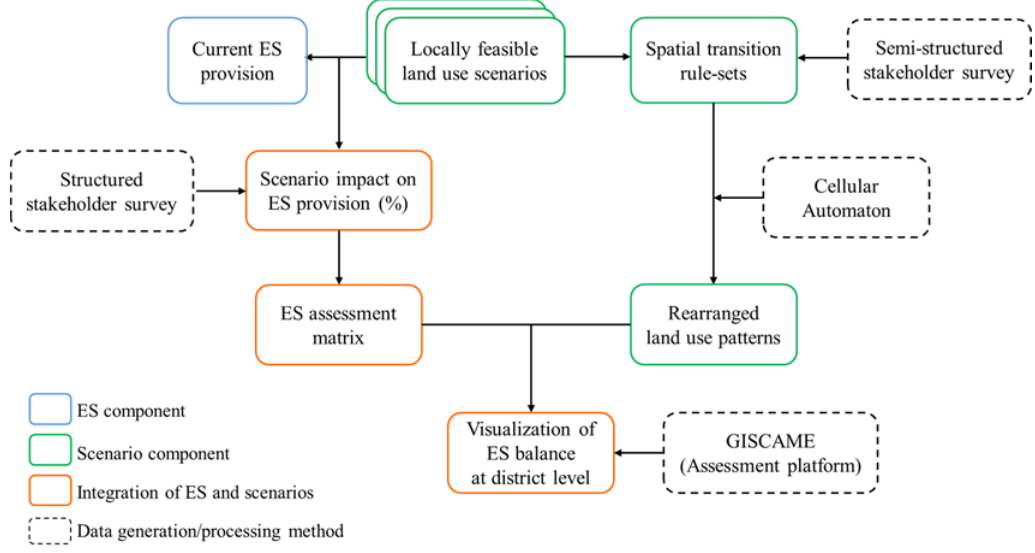
Figure 3. Integrative assessment process of ecosystem services and land use scenarios.